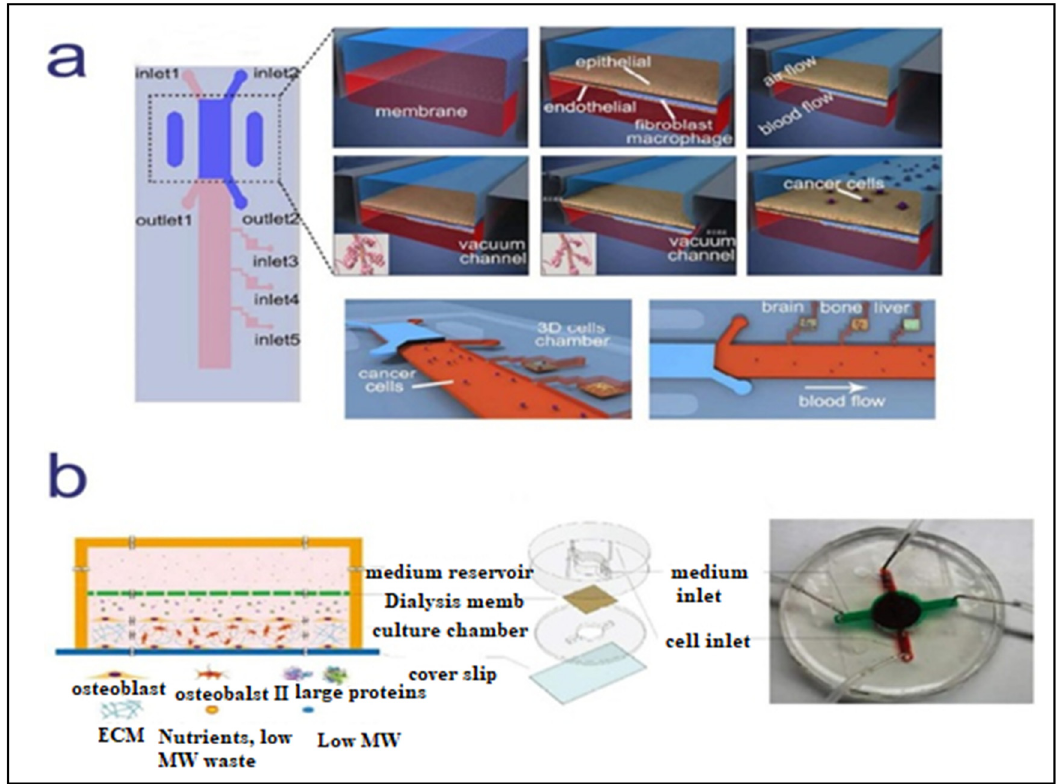
Figure 5: Cancer models based on micro fl uidic chips; ( a ) a multiorgan micro fl uidic chip that mimics LC metastasis in the brain, liver, and bone; ( b ) cancer model to study breast cancer metastasized to bone marrow. Reprinted from ref. [ 9 ] by Creative Commons